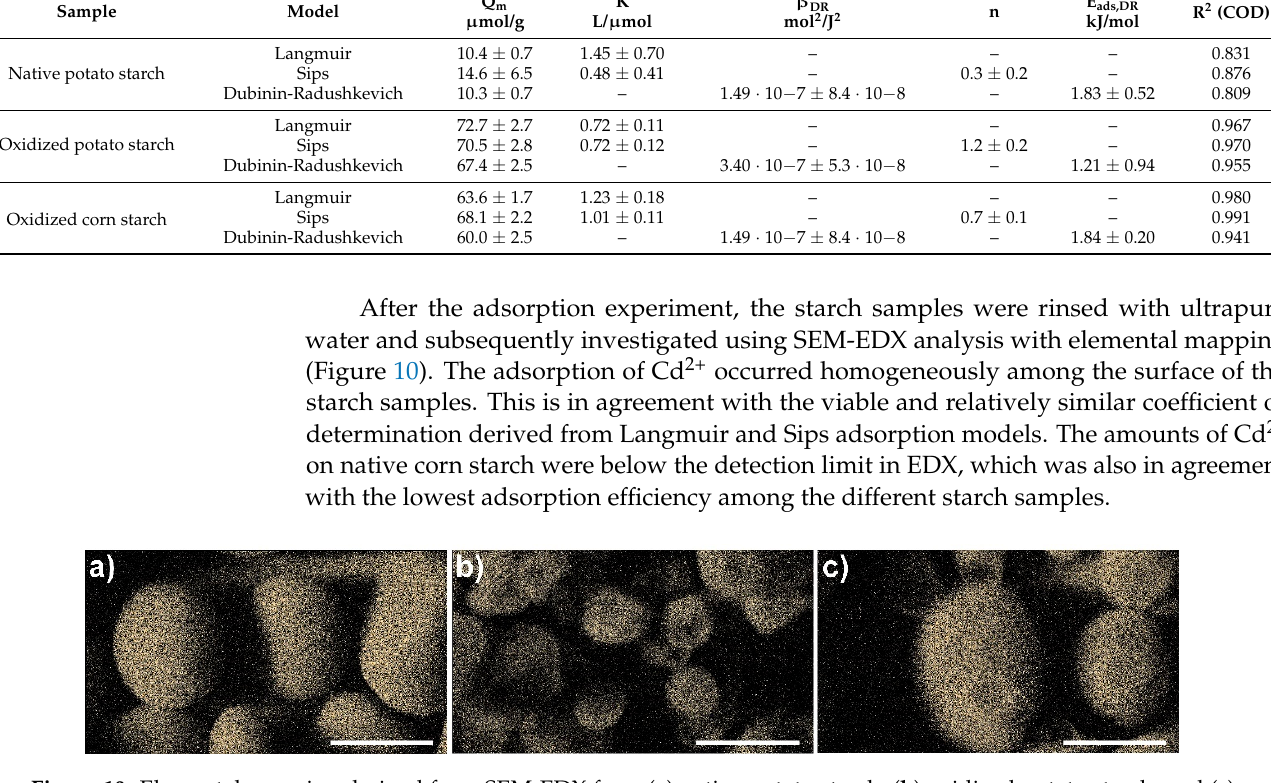
Figure 10. Elemental mapping derived from SEM-EDX from ( a ) native potato starch, ( b ) oxidized potato starch, and ( c ) oxidized corn starch after adsorption experiments with CdSO 4 solution Cd in yellow at 10,000-fold magnification. For native corn starch, the adsorbed amounts of Cd 2+ were below the detection limit for SEM-EDX. Scale bar is 15 µm.